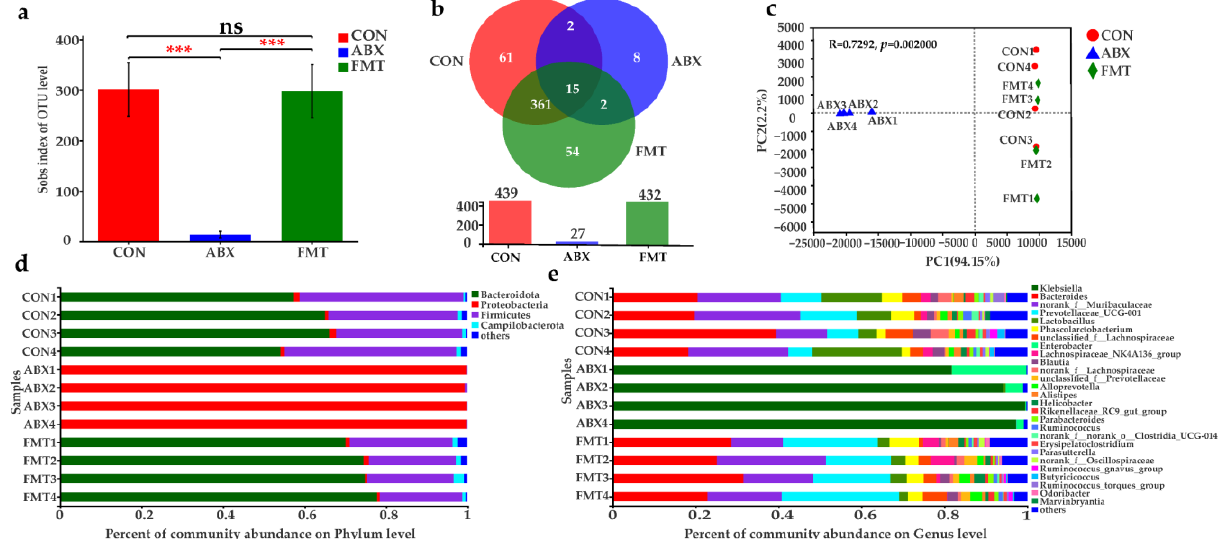
Figure 10. Characterization of the gut microbiota in mice after Abx treatment and FMT. ( a ) Index group difference test based on Student’s t test. ( b ) Species Venn diagram analysis OTU number. ( c ) Principal Component Analysis (PCA) of gut microbiota. ( d ) Relative abundance of microbiota at the phylum level. ( e ) Relative abundance of microbiota at the genus level. The “ns” indicated there was no significant difference between the groups ( p > 0.05). *** p < 0.001.